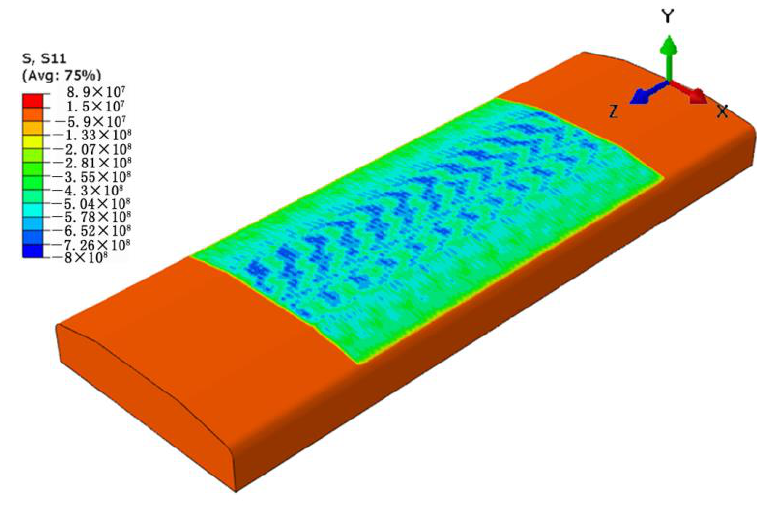
Figure 4. Simulated 3D residual stress filed of the LSP-treated specimen.